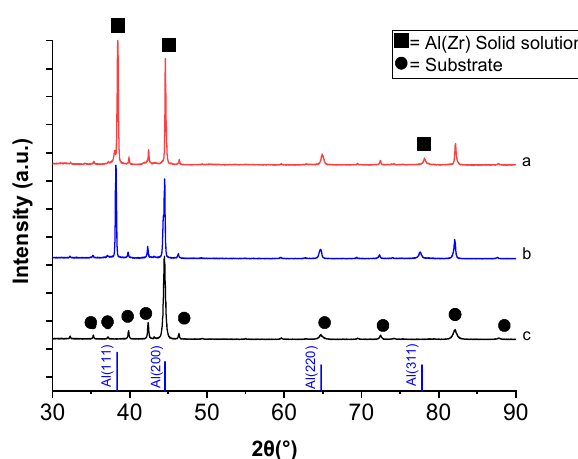
Figure 3. XRD patterns for the ( a ) HSS substrate, ( b ) as-deposited Al–Zr film on high-speed steel substrate, and ( c ) Al–Zr film annealed in the air at 500 °C.